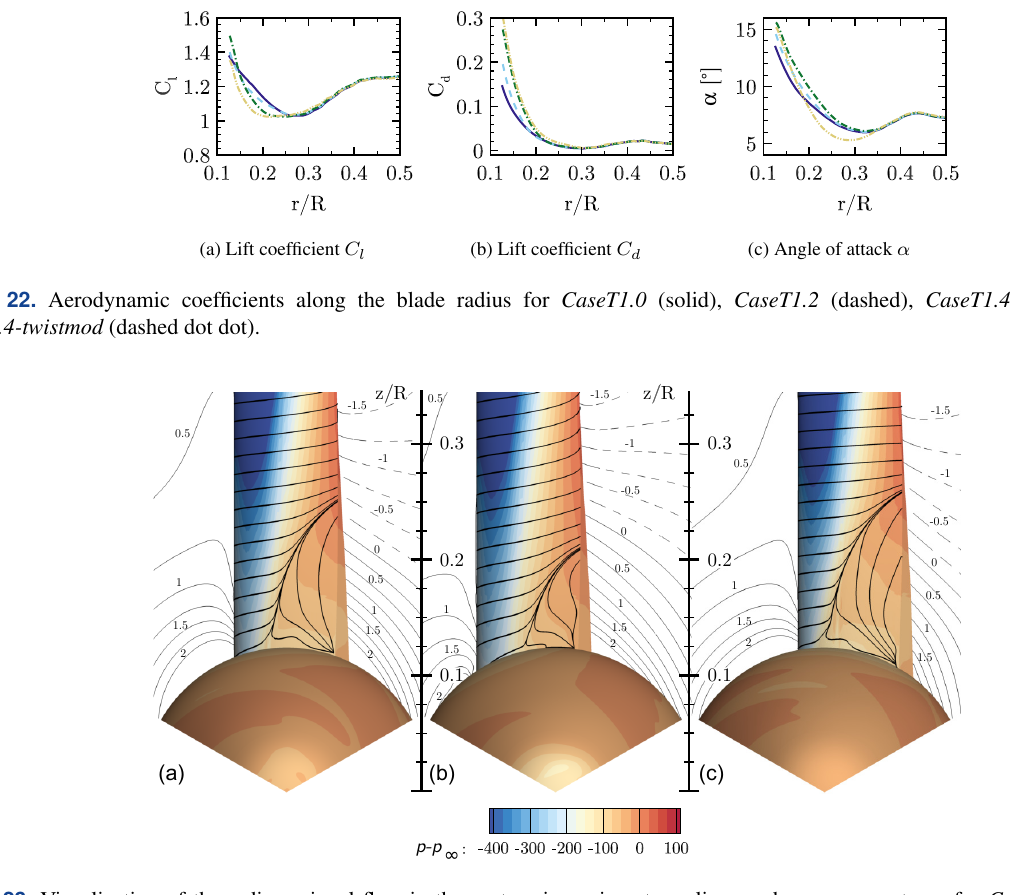
Figure 23. Visualization of three-dimensional flow in the root region using streamlines and pressure contours for CaseT1.4-dXm04 (a) , CaseT1.4-dYm05 (b) and CaseT1.4-dYp05 (c) . The contour lines are plotted for a slice at x = 2m ( x = 1 . 5m for CaseT1.4-dXm04 ) and indicate the velocity e w = w − (cid:127)y , which denotes the deviation from the ideal kinematic